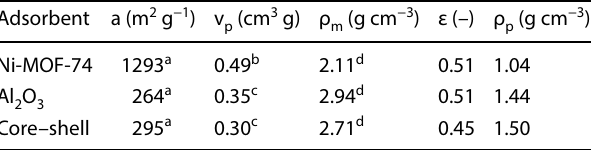
Table 1 Specific surface ( a ), pore volume ( v p ), material density ( 𝜌 m ), void fraction ( 𝜀 ) and particle density ( 𝜌 p ) of Ni-MOF-74, Al Ni-MOF-74@Al O core–shell composites 2 3